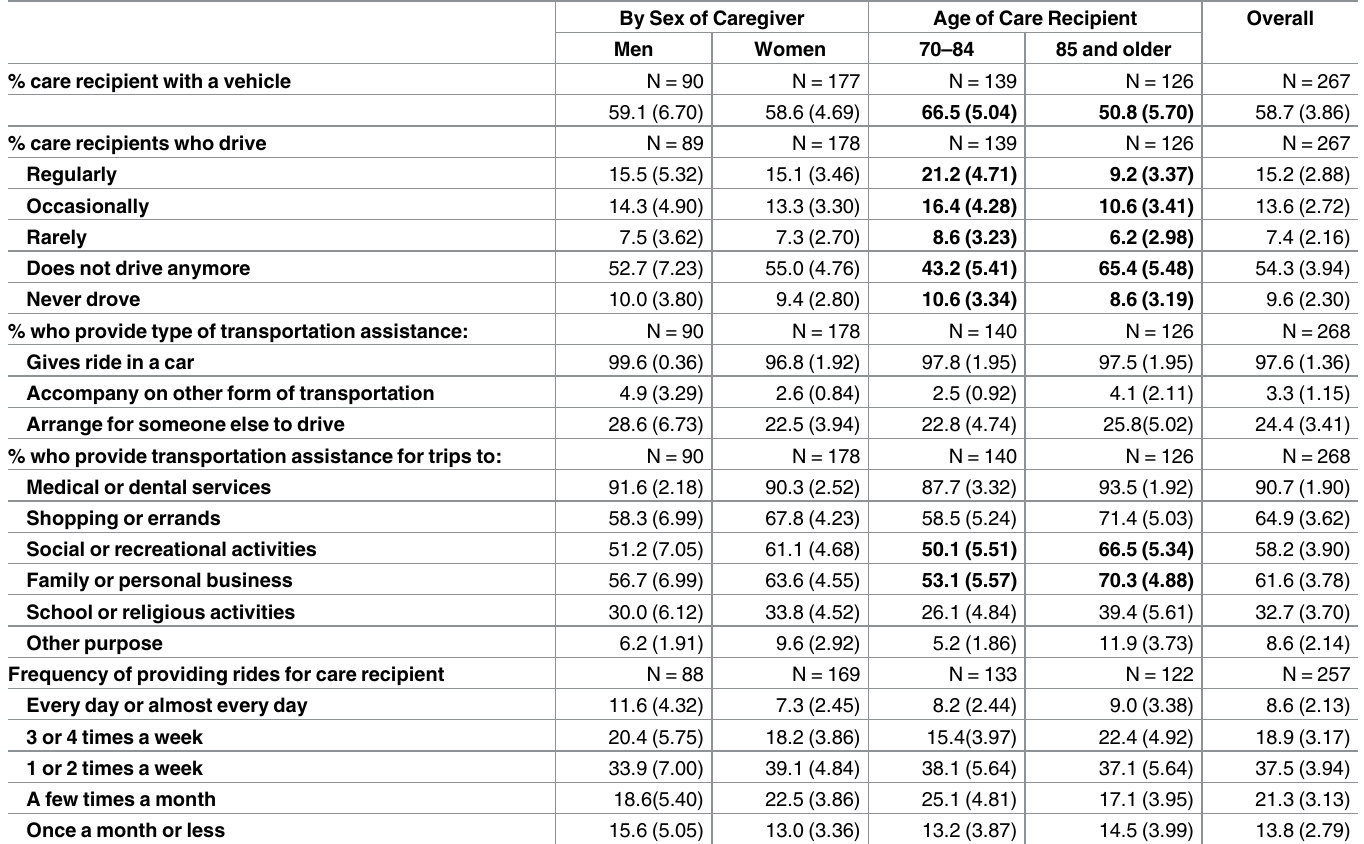
Table 5. Driving and transportation assistance by caregiversex, age of caregiver’s care recipient, and statewide (standard error of the percent/ mean).